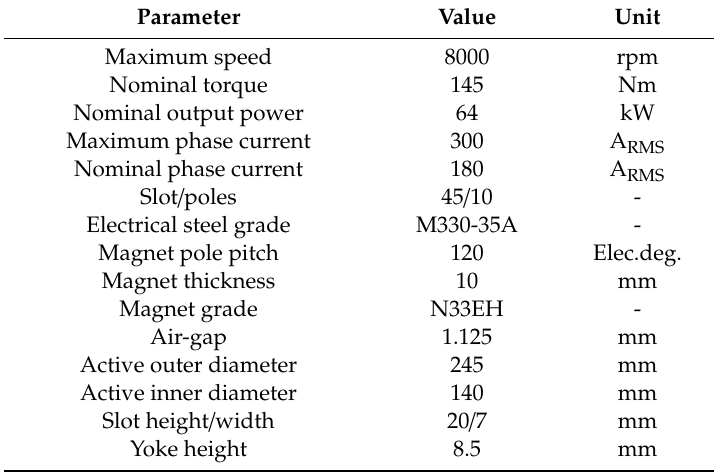
Table 1. Details of the prototype AFPMSM.